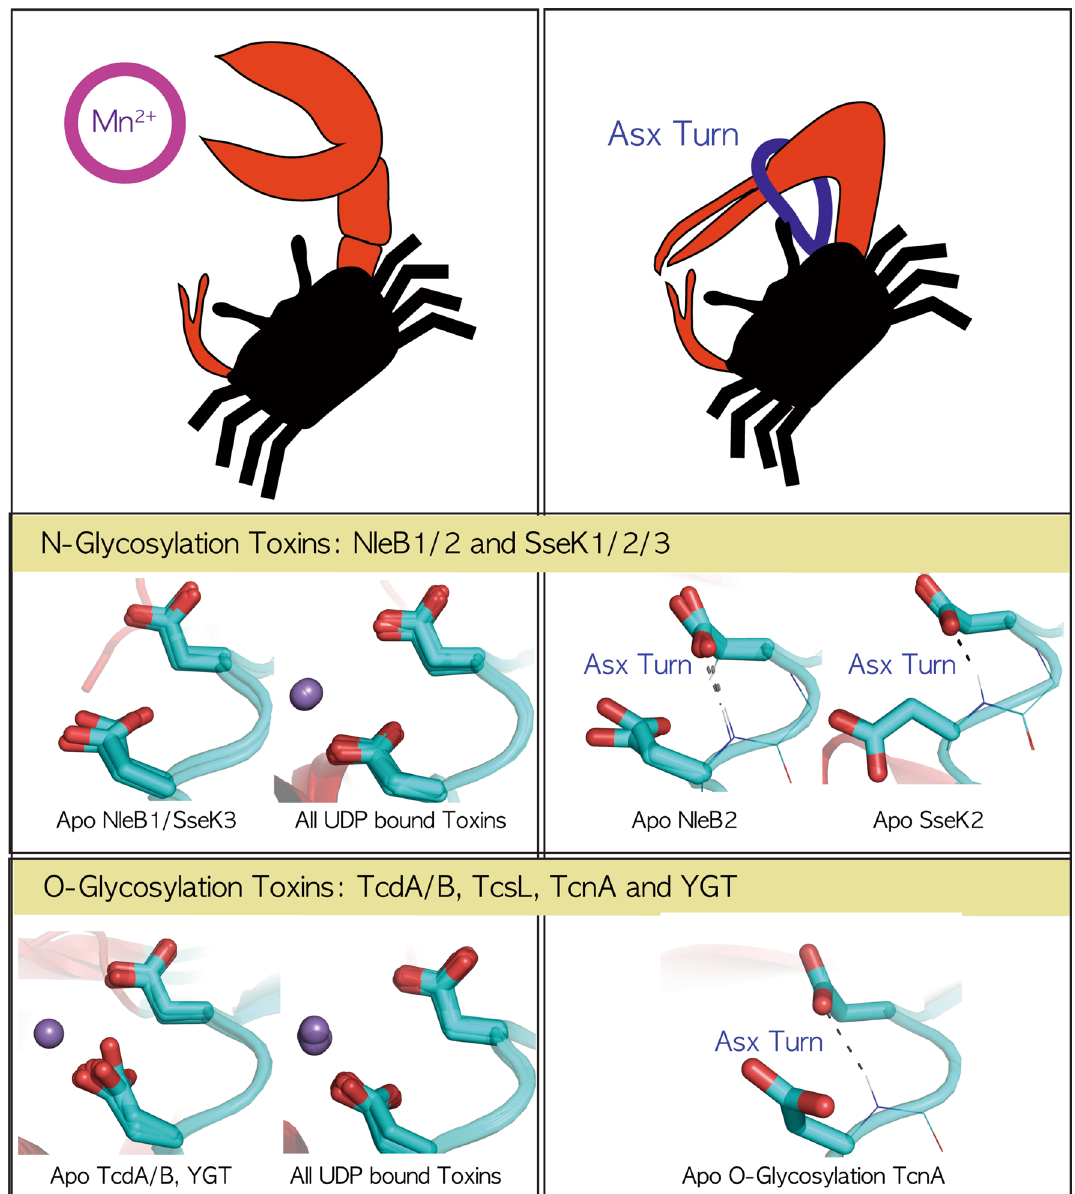
Figure 7. Cheliped-like Aspartate Dn of the DxD motif in bacterial glycosylation toxins. Except for the three toxins in apo NleB2, the SseK2 and TcnA toxins with a DxD motif tightly tied to the Asx-turn, the DxD motif